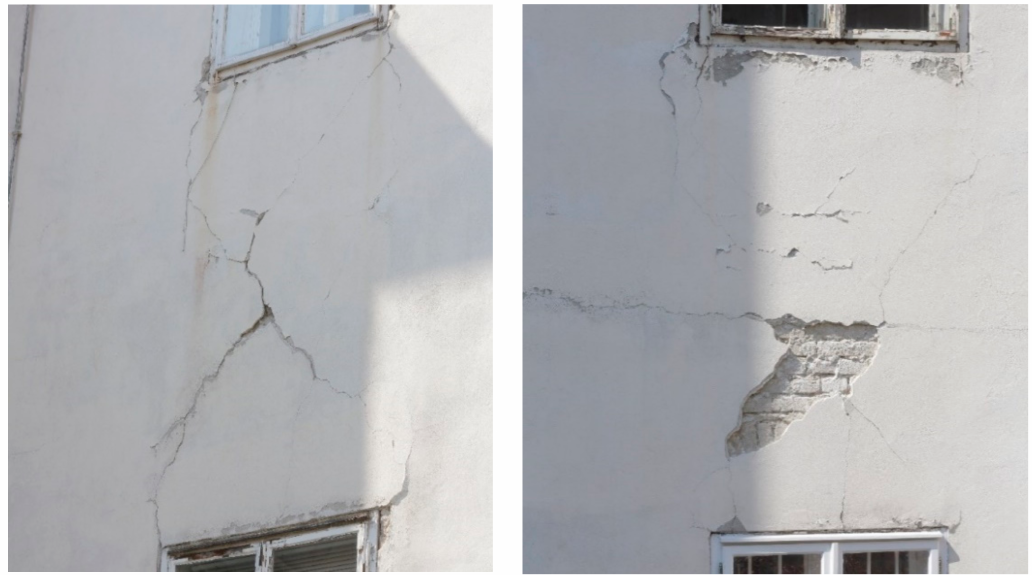
Figure 8. Diagonal X-pattern cracks on parapet walls between the first and second